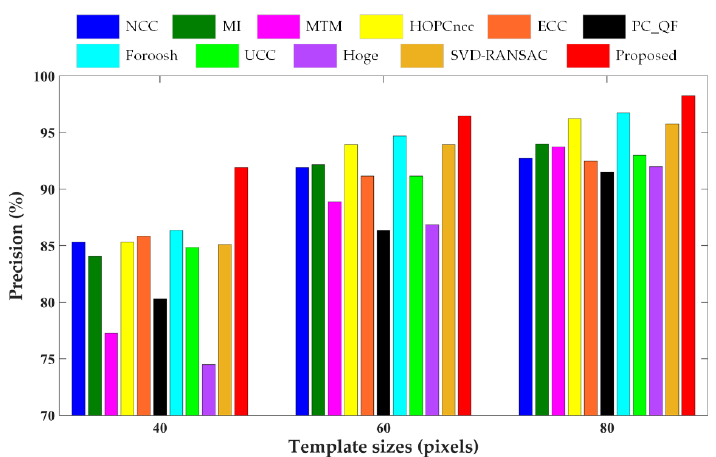
Figure 6. Precision values of different methods for Data 3.